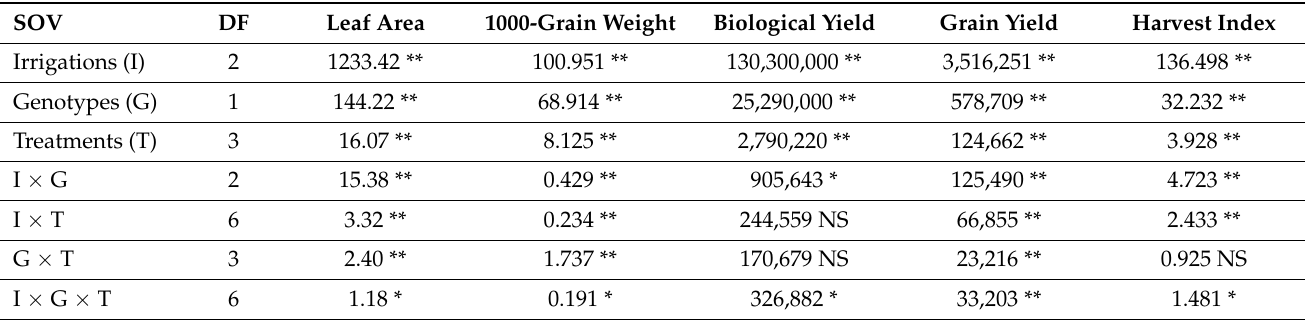
Table 3. Analysis of variance (mean sum of squares) of leaf area, 1000-grain weight, biological yield, grain yield and harvest index of triticale genotypes cultivated under various irrigation regimes in response to NPK and organic amendments.